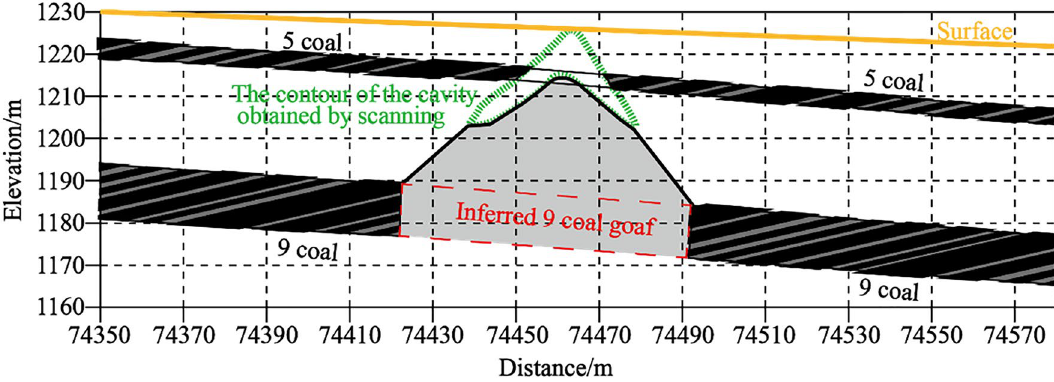
Figure 14. Spatial location of cavity 1225 pingpan 0528 in East open-pit Mine. As shown in the figure, according to the contour of the cavity obtained by scanning, this cavity has collapsed to the surface, the roof of No.9 coal mined-out area collapsed locally and inferred that the north–south span of 9 coal goaf is about 70 m.